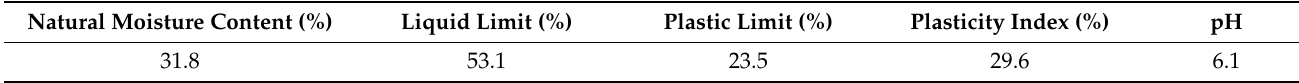
Table 1. Fundamental physical parameters of high liquid limit soil.